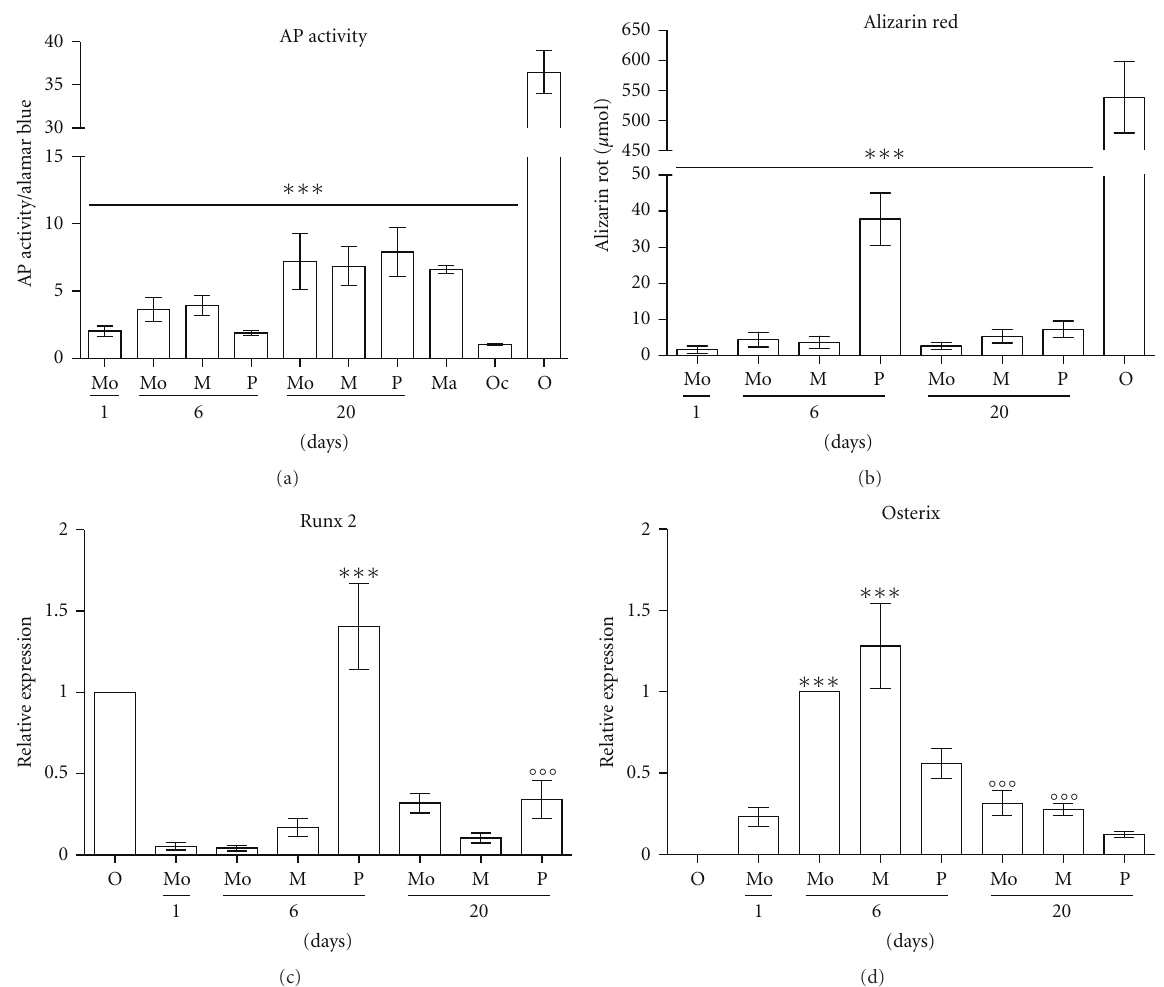
Figure 3: Weak response of monocyte-derived cells to di ff erentiation. (a) Alkaline phosphatase (AP) activity [ μ mol/min] of monocyte- derived cells in comparison to primary osteoblasts, macrophages, and osteoclasts ( N = 4, n = 3). AP activity [ μ M/min] normalized to cell amount determined by Alamar blue. (b) Alizarin red measurement [ μ mol] in monocyte-derived cells in comparison to primary osteoblasts ( N = 4, n = 3). (c) Relative expression levels of Runx2 measured by RT-PCR normalized to GAPDH and subsequently to expression in primary osteoblasts as internal control ( N = 3, n = 3). Runx2 expression significantly increases after treatment to obtain PCMOs ( ∗∗∗ P < 0 . 001). After the di ff erentiation procedure, Runx2 expression in PCMOs decreases again ( ◦◦◦ P < 0 . 001) (d) relative expression levels of Osterix measured by RT-PCR normalized to GAPDH and subsequently to expression in monocytes after 6 days in culture as internal control ( N = 3, n = 3). Osterix expression significantly increases after treatment to obtain MOMPs and after 6 days culture of control monocytes ( ∗∗∗ P < 0 . 001). After the di ff erentiation procedure, osterix expression in both cell types decreases again ( ◦◦◦ P < 0 . 001). Monocytes (Mo) day 1: freshly isolated monocytes; Mo, MOMP (M), and PCMO (P) day 6: cells after treatment; Mo, M, P day 20: cells after di ff erentiation with vitamin-D-containing medium. Macrophages (Ma), osteoclasts (Oc). ( ∗∗∗ P < 0 . 001).